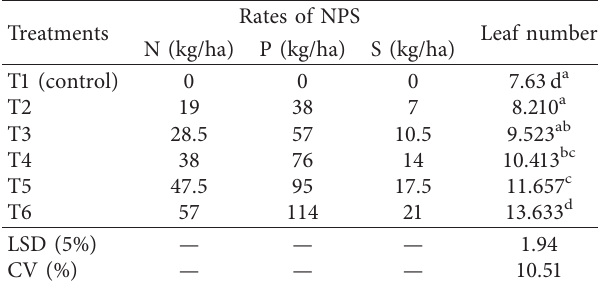
Table 1: Effect of different rates of NPS on days to 50% emergence.